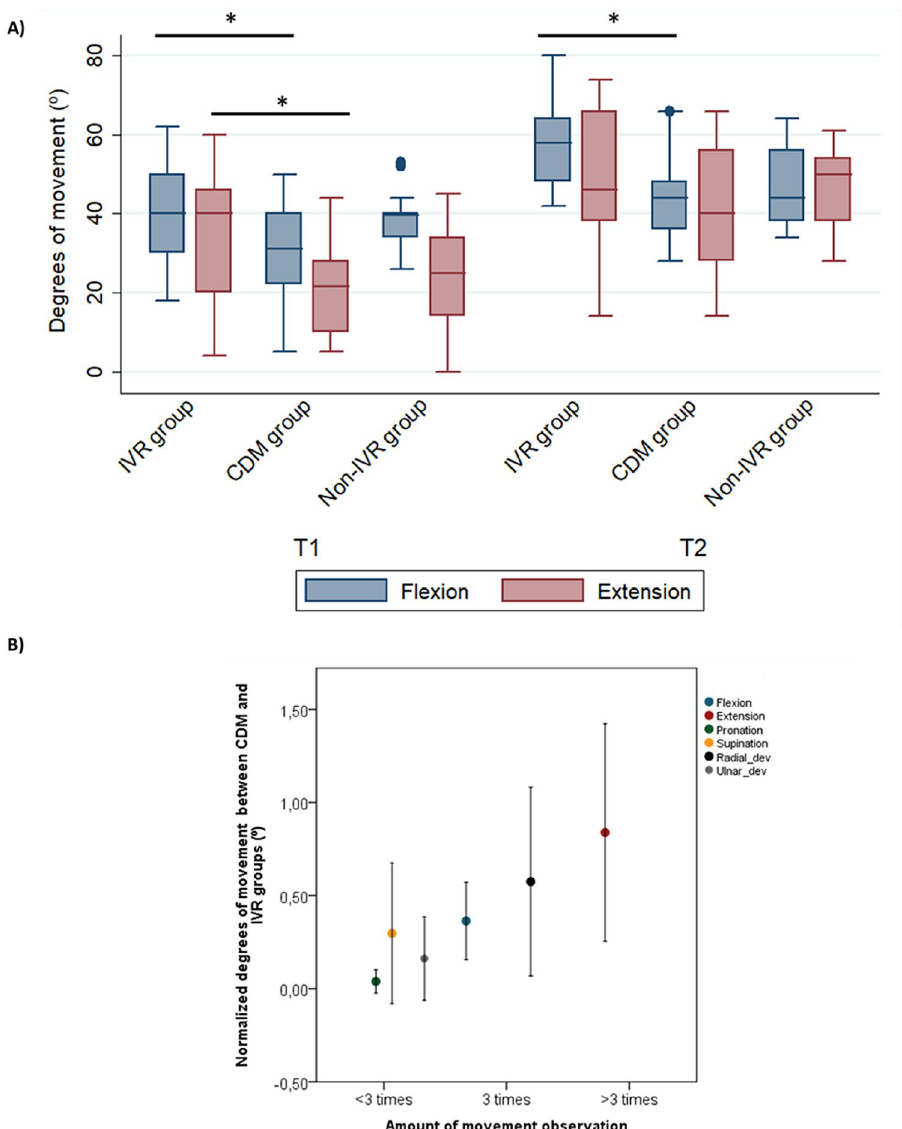
Figure 3. Range of motion improvement and the relationship with the amount of movement visualization. ( A ) In the range of motion assessment, the immersive VR training group presented more degrees of movement in wrist flexion/extension movements after cast removal (T1) compared to the CDM group. Again, six weeks later (T2) the immersive VR group presented greater degrees of motion than the CDM group in wrist flexion movement. The lines show the difference of degrees of motion for each different movement between groups in the T1 and T2 assessments. Error bars represent 95%CI. * p < 0.05, ** p < 0.01. ( B ) The amount of movement visualization is linked with range of motion improvement. Differences between the immersive VR and CDM groups are possibly due to patients in the immersive VR group visualizing joint movements during the training period; furthermore, the patients in immersive VR group presented higher recovery in those movements that they visualized more times during the training period. Error bars represent 95%CI of the